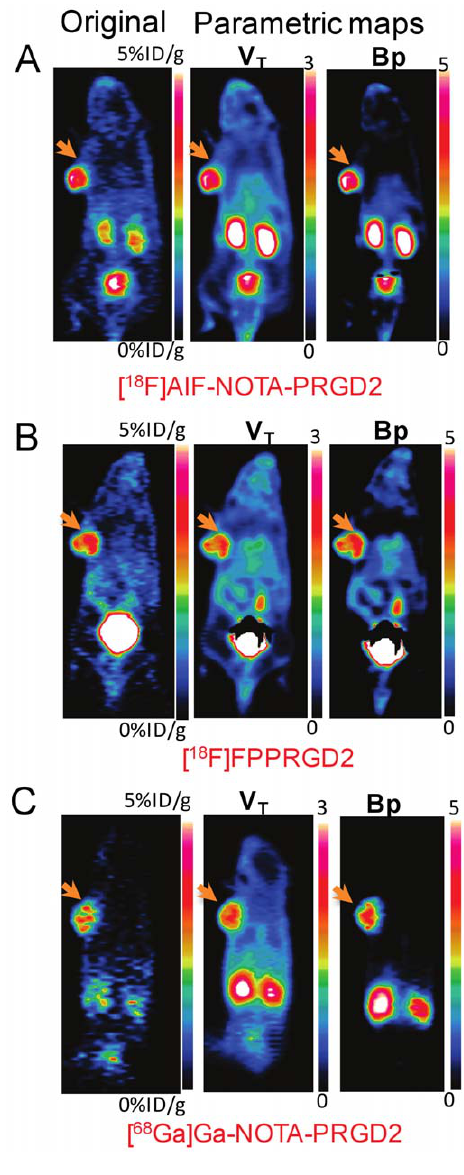
Figure 7. Representative original static PET images at 60 min (left), parametric maps of volume of distribution (middle) and binding potential (right) for RGD peptide tracers. ( a ) [ 18 F]AlF- NOTA-PRGD2, ( b ) [ 18 F]FPPRGD2, and ( c ) [ 68 Ga]Ga-NOTA-PRGD2. The arrows point to tumors. doi:10.1371/journal.pone.0037506.g007 radiotracer ([ 18 F]AlF-NOTA-PRGD2, [ 18 F]FPPRGD2 or [ 68 Ga]- Ga-NOTA-PRGD2, n= 4/group) under isoflurane anesthesia. During the acquisition period, a thermostat-controlled thermal heater maintained the body temperature of mice. PET images were reconstructed with 2 iterations of 3-dimensional ordered- subsets expectation maximum (3D OSEM) with 14 subsets, followed by 18 iterations of maximum a posteriori (MAP) algorithm with a smoothing parameter of 0.1 (frame rates: 10 6 30 s, 5 6 60 s, 5 6 120 s and 10 6 240 s). No attenuation correction was performed in this study.